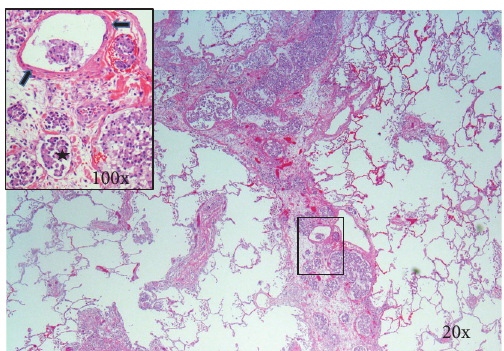
Figure 2: Section of postmortem lung tissue demonstrating thick- ened edematous interlobular septum with numerous dilated lym- phatic channels filled with malignant glandular cells (starred in inset). Inset also shows tumor cells in venous channels with thicker walls (arrows). Hematoxylin and eosin.